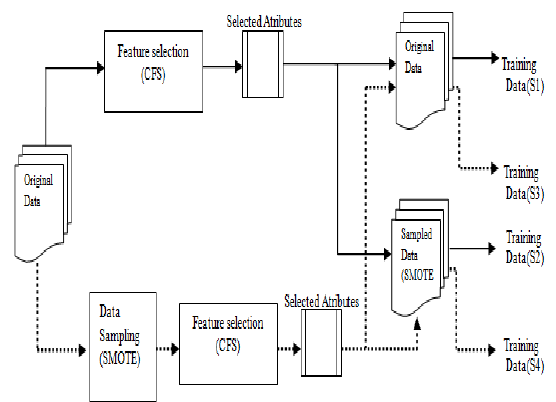
Figure2. Feature selection and data sampling